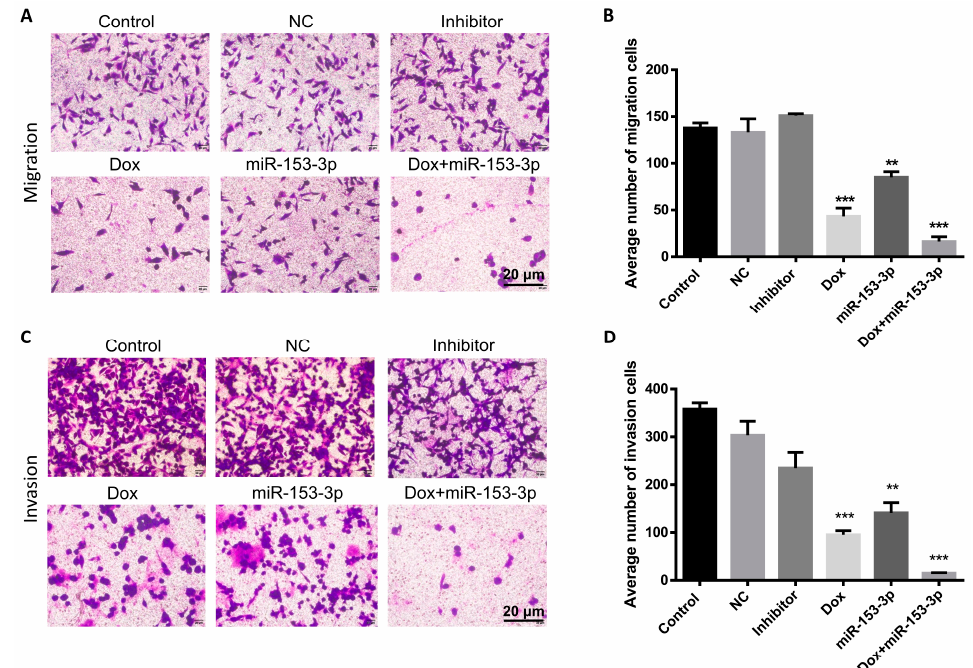
Cancers 2023 , 15 , x FOR PEER REVIEW Figure 6. miR-153-3p, Dox, and miR-153-3p+Dox treatment inhibited migration ( A , B ) and invasion ( C , D ) of MCF-7 cells (** p < 0.01; *** p < 0.001).